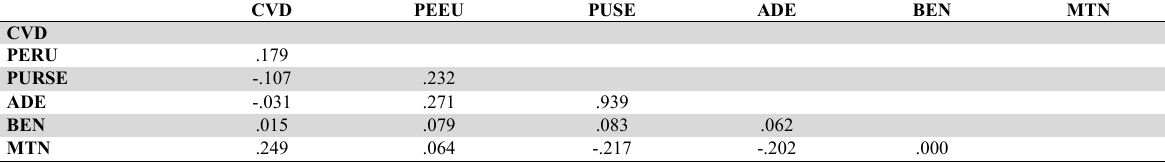
Heterotrait-Monotrait Ratio